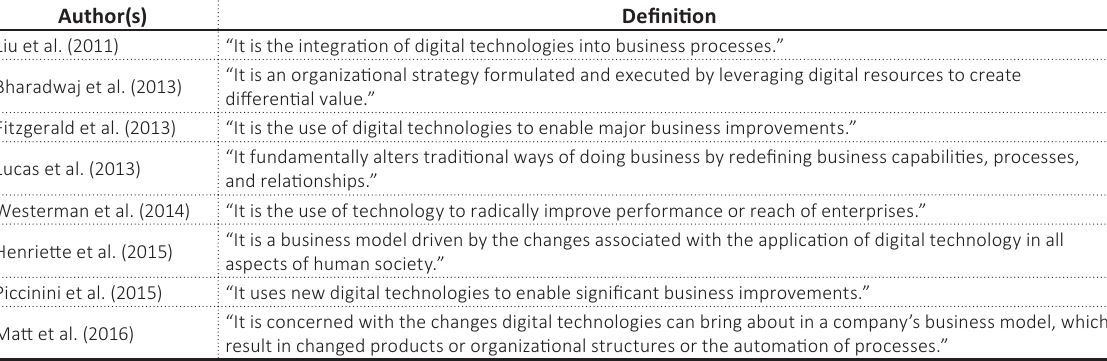
Table 1. Definitions of digital